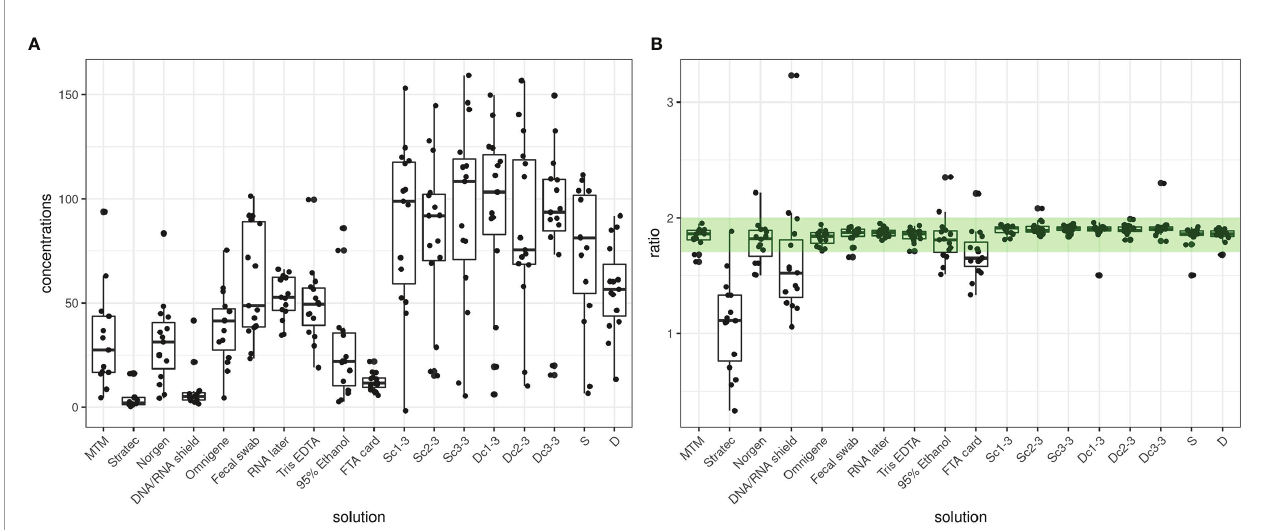
FIGURE 2 | Quantity and quality of DNA extracted from human fecal samples. (A) DNA yield, expressed as ng/µl. (B) A 260/280 nm ratio indicative of the presence or absence of phenol, solvent and protein-type contaminants in the DNA extract. The green range indicates a ratio between 1.7 and 2.0, which here de fi nes an optimal DNA quality.